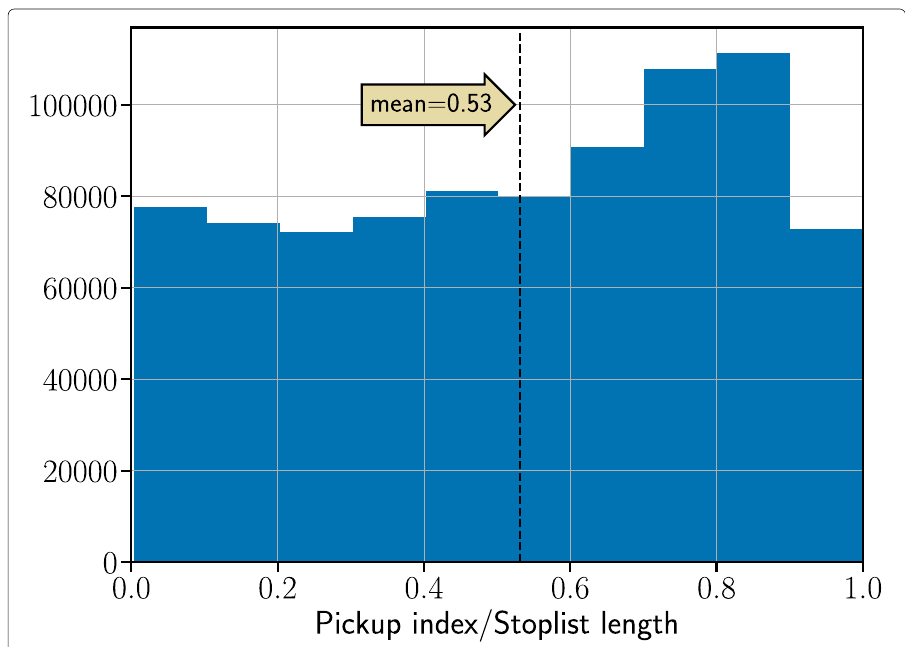
Fig. 9 Illustration of the non-uniformity of the pick-up location in a stoplist. A pick-up is more likely to be located near the end of a stoplist than near the beginning, for simulations done on the 100 node ring